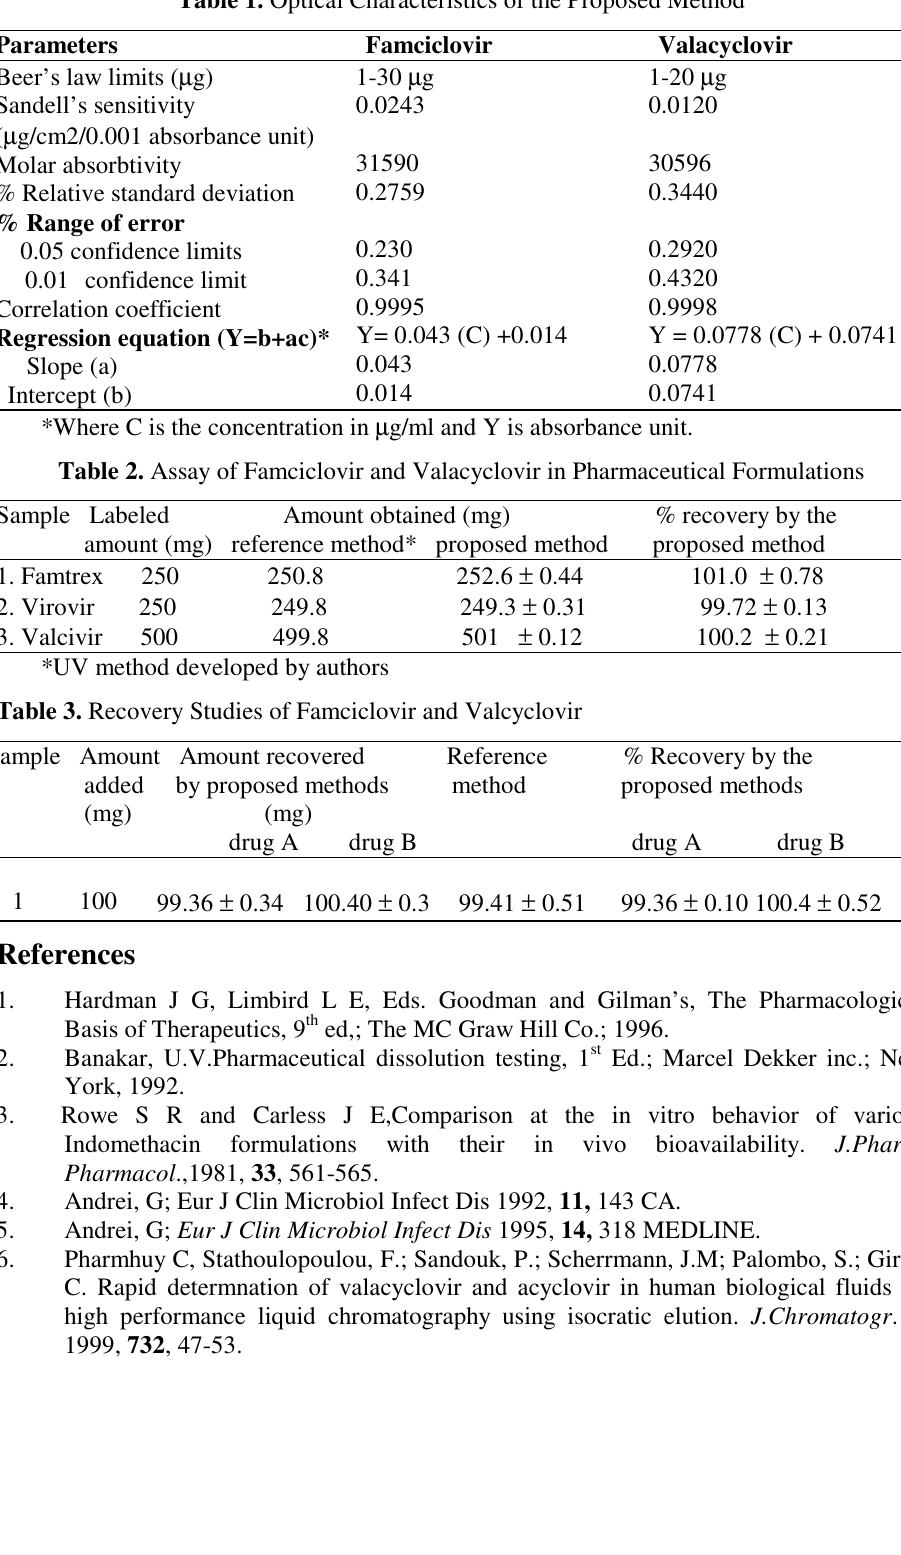
Table 1. Optical Characteristics of the Proposed Method